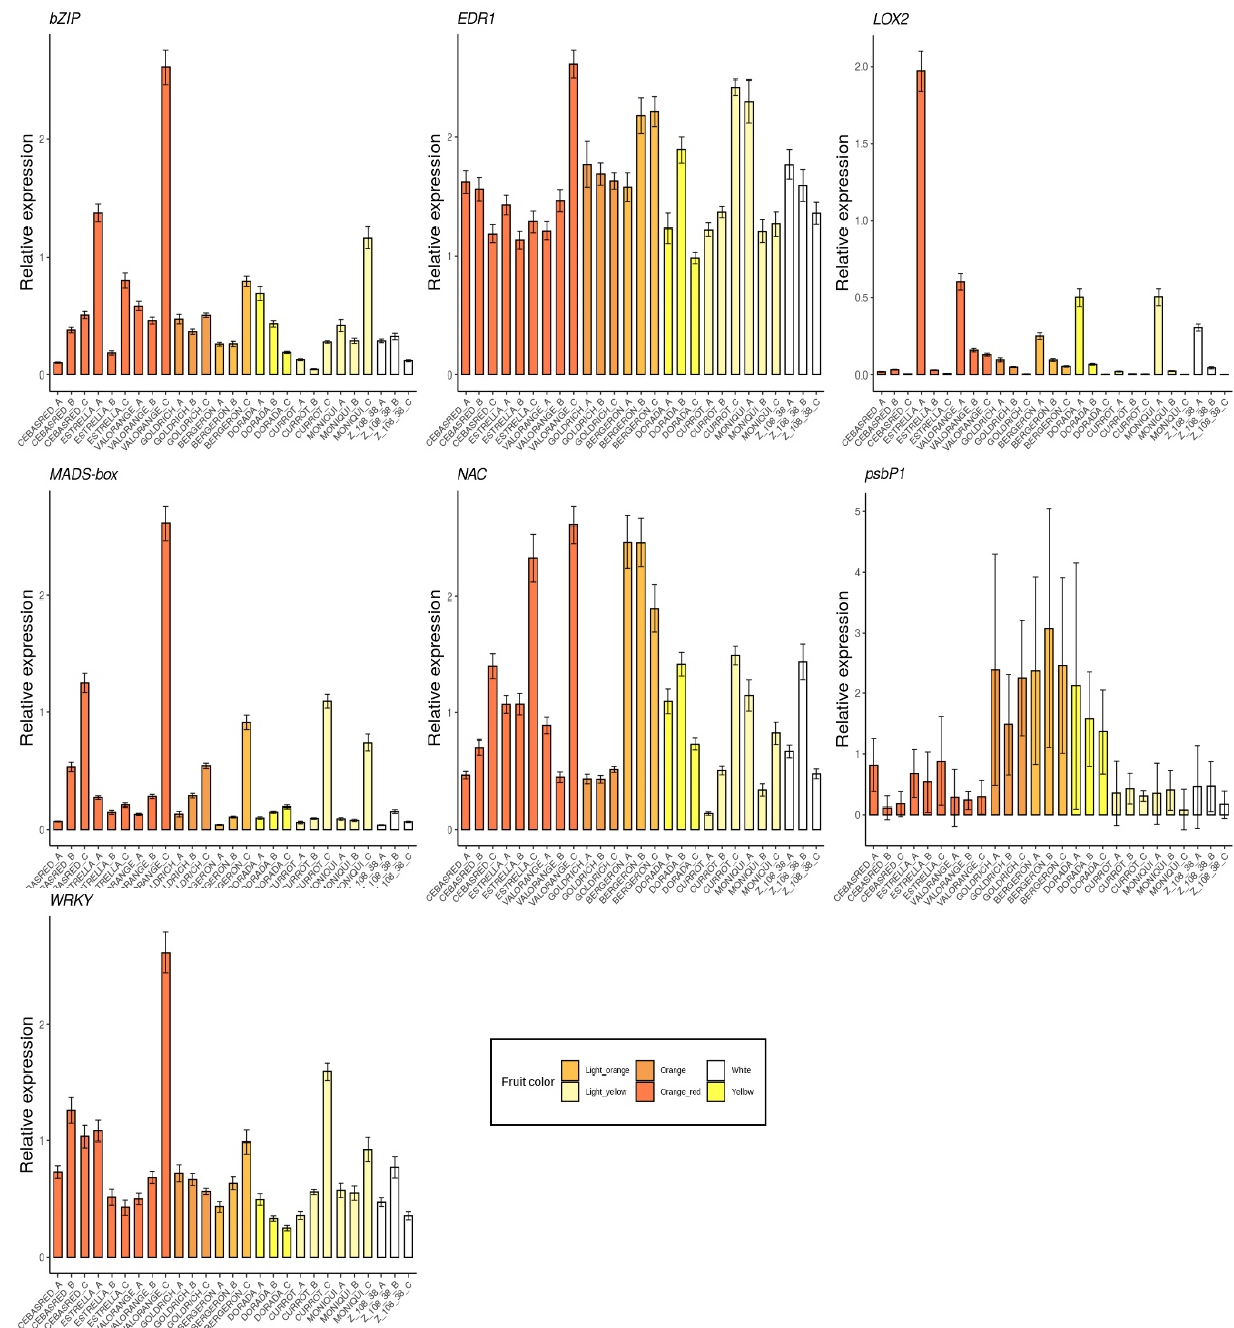
Figure 8 . Barplots of the expression dynamics of others genes involved in the regulation of ripening progress, as bZIP, EDR1, LOX2, MADS-box, NAC, psbP1 and WRKY , in the nine cultivars ‘Bergeron’, ‘Cebasred’, ‘Currot’, ‘Dorada’, ‘Estrella’, ‘Goldrich’, ‘Moniquí’, ‘Valorange’ and ‘Z 108-38 ′ at three different ripening stages based on their skin ground color and firmness: green fruit (_A), during color change (_B) and at physiological ripening (_C).